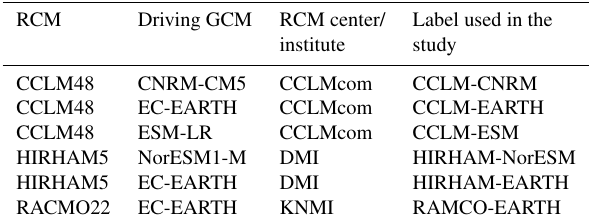
( Vigna unguiculata ), and groundnut ( Arachidis hypogaea ) are the major crops cultivated in the catchment.